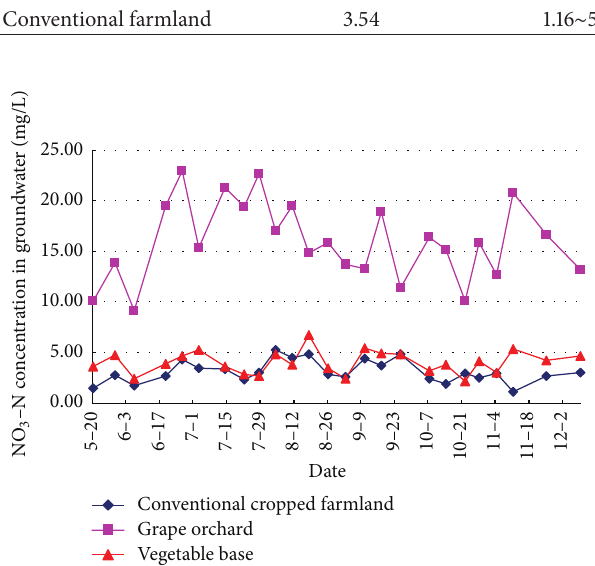
Figure 9: Change of NO 3 -N concentrations in shallow groundwater of three kinds of typical cropped